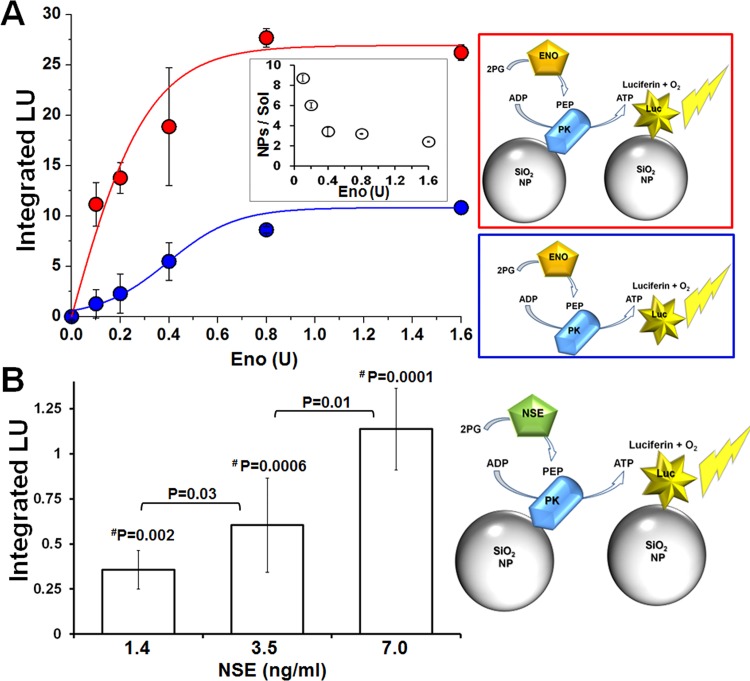
Improved sensitivity for enolase detection via its enzymatic activity when using tethered PK and Luc.
A) Comparison of the detection sensitivity for enolase activity (Eno) as measured by NP-PK + NP-Luc (red) vs. PK + Luc in solution (blue). Increasing concentrations of Eno were added to immobilized or freely diffusing enzymes in reaction buffer. Luminescence was detected and integrated over 10 minutes at RT and plotted against Eno final unit amount (lines were added to guide the eye). The inset shows the ratio of the enzymes’ activities on NPs versus in solution as a function of units of ENO. Data presented as AVG±STDEV. B) NSE detection via PK and Luc coupled activity was performed as indicated in the schematic illustration (right). His-Si-PK and His-Si-Luc were immobilized on 500 nm NPs and mixed with reaction buffer supplemented with increasing concentrations of human NSE. Luminescence readout was normalized to t0 (first read) values and plotted as a function of time. Then, the luminescent signal was integrated for first 10 minutes, and a reading from the zero NSE well was subtracted from the collected signal. The sensitivity of the tethered enzyme assay was about 5 times higher than the reported average physiological NSE blood concentration (8.7 ± 3.9 ng/ml [24]). P values were calculated using student’s t-test for comparisons between NSE concentrations; values marked with #P were calculated for significance when compared against 0 ng/ml NSE.